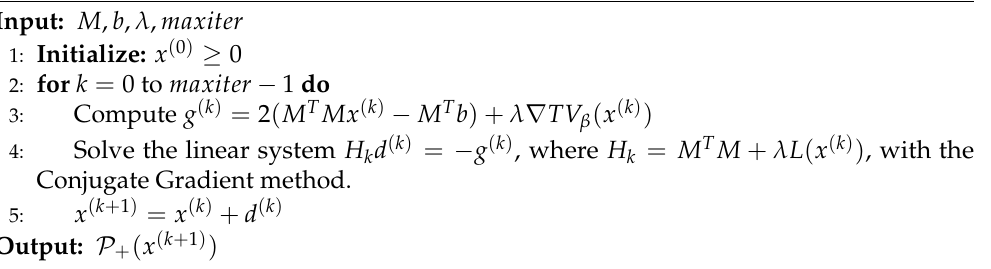
Algorithm 2 Lagged diffusivity Fixed Point algorithm